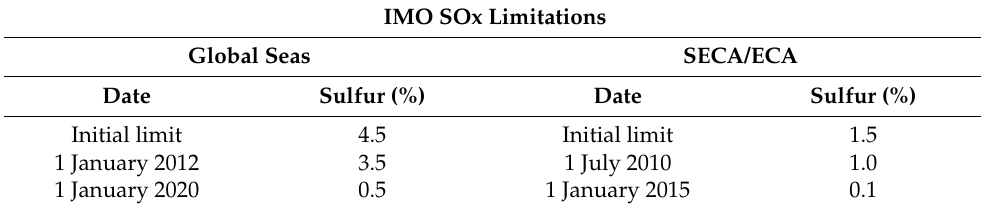
Table 2. Introduced limitations by IMO [41].